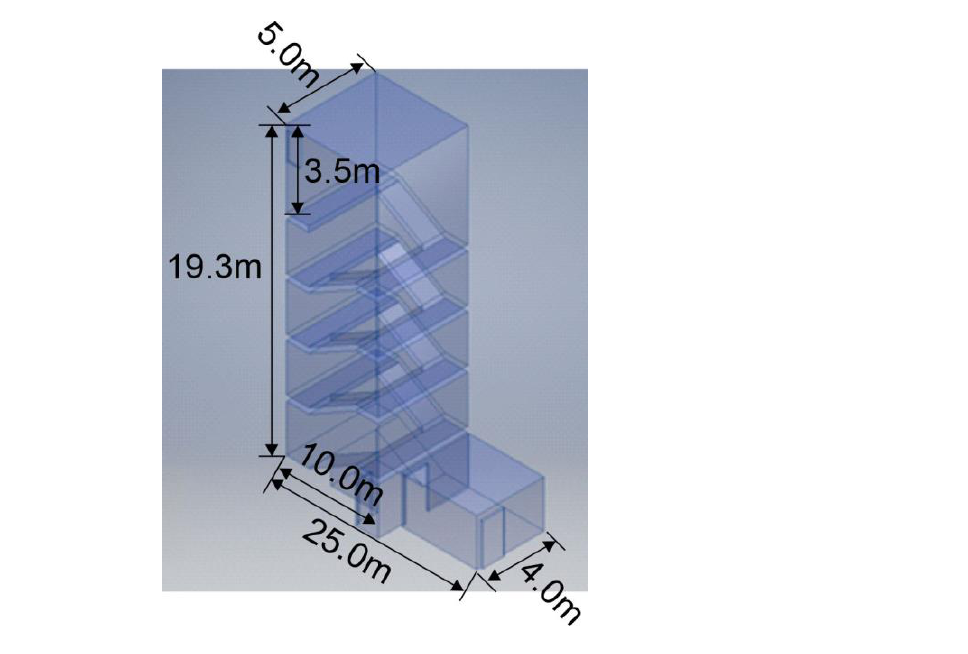
Figure 1. 3D geometry of the analyzed building, generated with the use of Ansys SpaceClaim soft- ware.